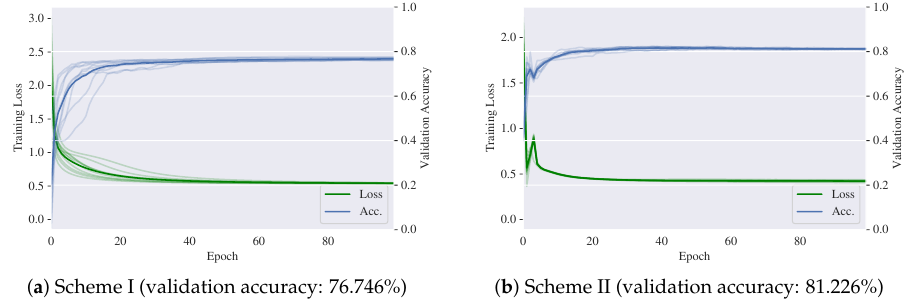
Figure 12. Training loss and validation accuracy of DiscNet on the Guangdong dataset (using 10% of data for training).